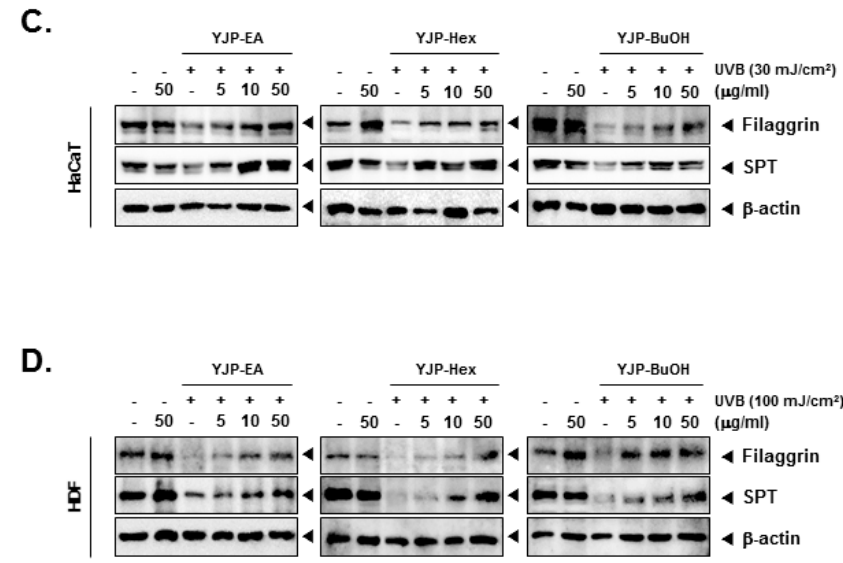
Figure 3. Moisture-recovery effects of YJP-EA, Hex, and BuOH on UVB-damaged HaCaT and HDF cells. ( A , B ) HaCaT and HDF cells were irradiated with UVB (30 or 100 mJ/cm 2 ) and treated with YJP-EA, Hex, and BuOH for 24 h. The hyaluronic acid was measured using a hyaluronan ELISA kit and detected with 450 nm. ( C , D ) The protein-expression levels of filaggrin and SPT were analyzed by Western blot analysis. All experiments were performed individually in triplicate. *** p < 0.001 vs. non-treated (NT) cells.